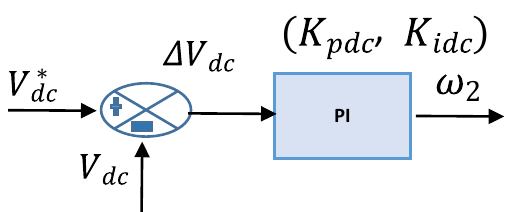
Fig. 5 DC link voltage controller